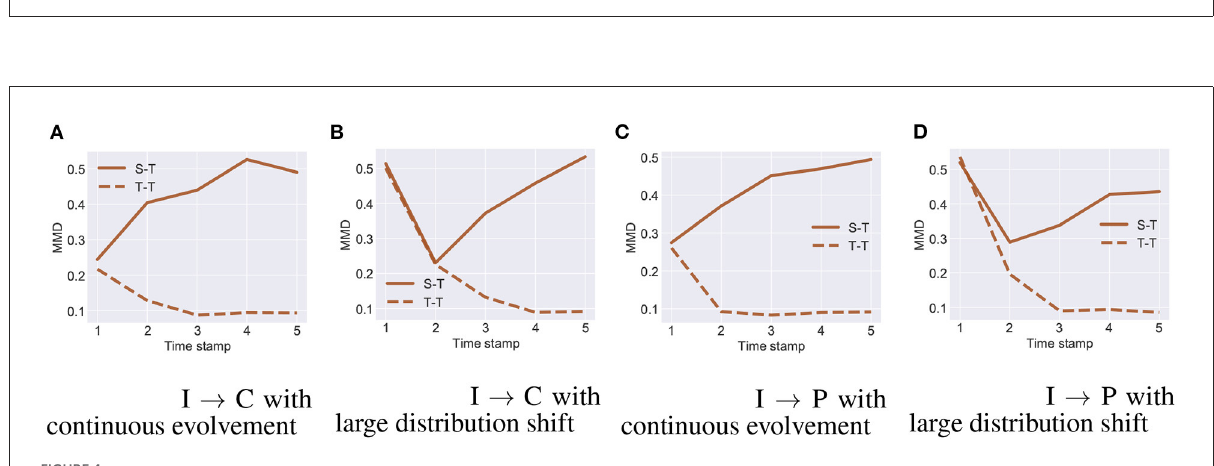
P on ImageCLEF-DA with (C) continuous evolvement, →